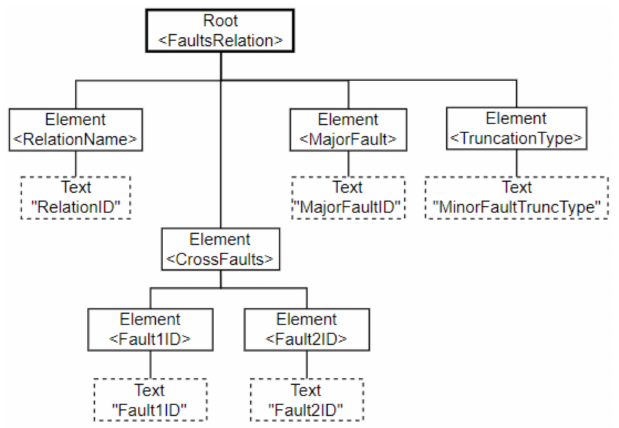
Figure 14. Diagram of XML structure of faults relationship